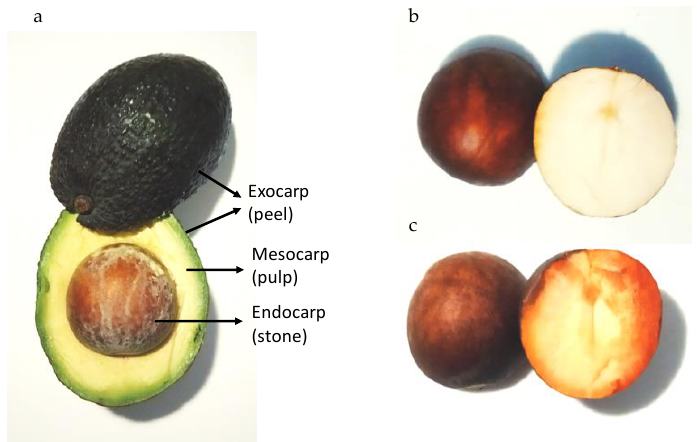
Figure 2. ( a ) Parts of the avocado fruit; stone split in half before ( b ) and after ( c ) partial oxidation, in the latter appearing the orange color.